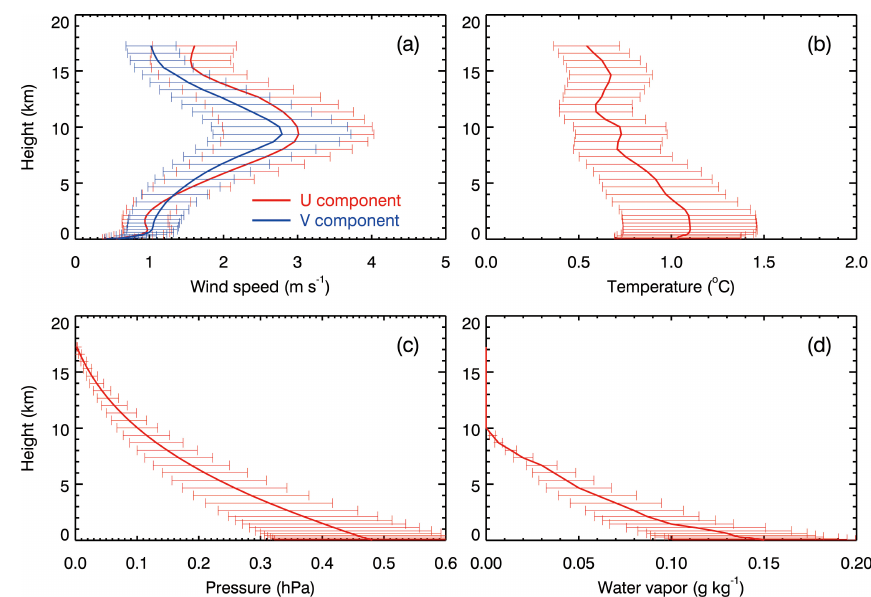
Figure 2. Vertical distribution of the mean of initial ensemble spreads and the standard deviation for (a) horizontal winds ( U and V compo- nents), (b) temperature, (c) pressure, and (d) water vapor mixing